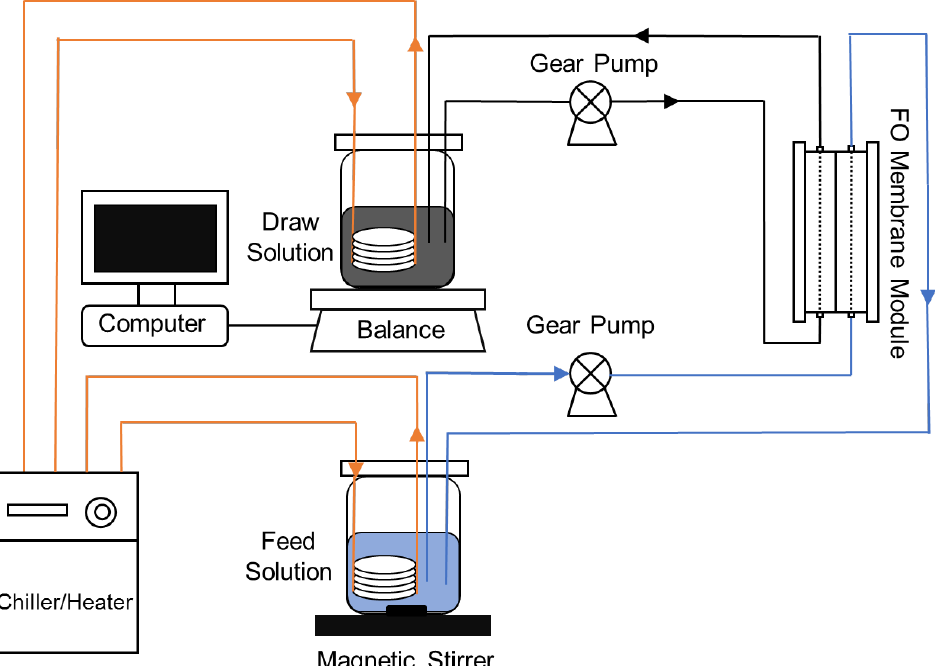
Figure 1. Schematic diagram of the bench-scale FO